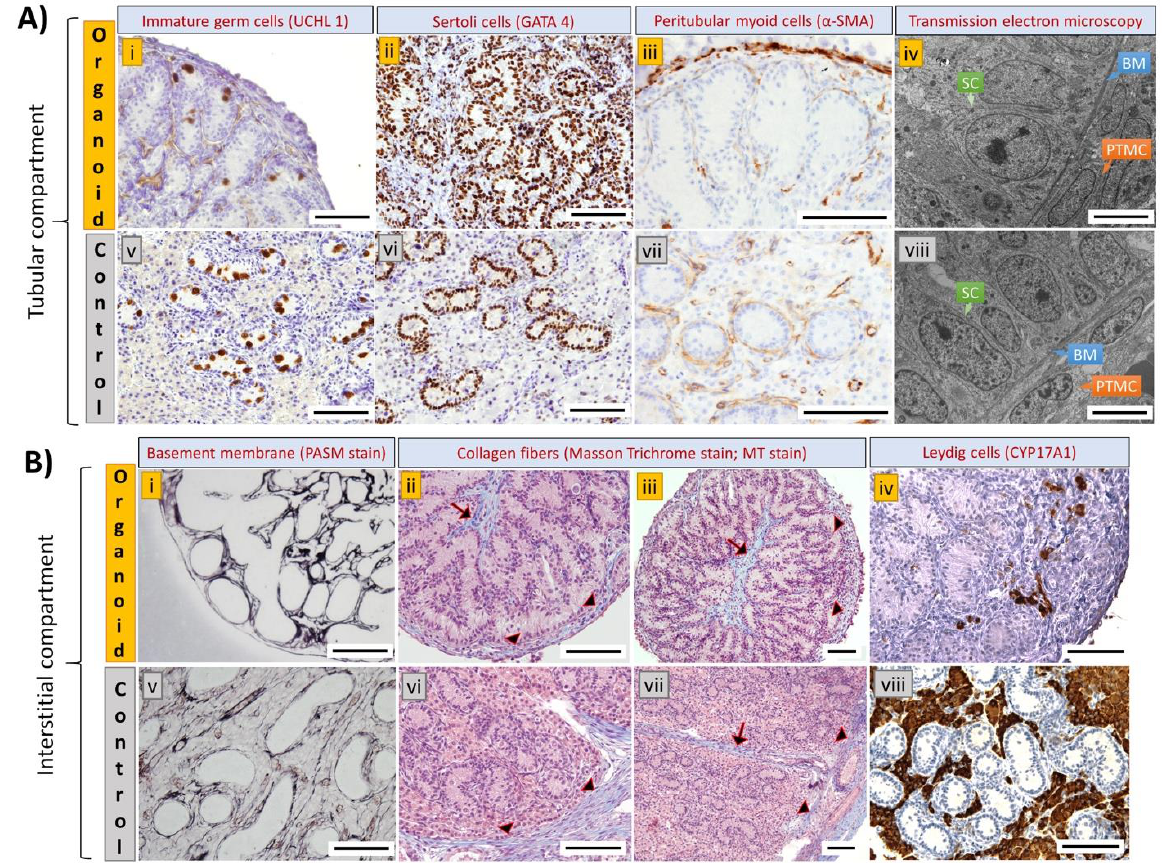
Figure 4. Immunohistochemistry, tissue-specific staining, and transmission electron microscopy (TEM) to detect tubular and interstitial compartments in testis organoids and intact testis tissues from 1-week-old piglets (positive anatomical controls). ( A ) Imaging of the tubular compartment in organoids (upper row) and intact testis tissue (lower row). Immature germ cells ( A ( i )), also known as gonocytes, were detected using UCHL1 and were observed within the tubular structures constructed by Sertoli cells ( A ( ii )) detected by GATA4, and peritubular myoid cells ( A ( iii )) detected by α -SMA. ( A ( iv )) A testis epithelium-like structure constructed by Sertoli cells (SCs), basement membrane (BM), and peritubular myoid cells (PTMCs) was observed in testis organoids as early as 1 week of culture. ( A ( v – viii )) Imaging of intact testis tissues (controls) with the corresponding cell types and structures. ( B ) Imaging of the interstitial compartment in organoids (upper row) and intact testis tissue (lower row). ( B ( i )) Peritubular basement membrane (black) was detected using periodic Schiff-methenamine (PASM) staining. ( B ( ii , iii )) Inter-tubular interstitium (arrows) and peripheral capsule (arrow heads) constructed by collagen fibers (blue) were detected in the organoids using Masson’s trichrome (MT). Also, Leydig cells ( B ( iv )) were detected by CYP17A and were observed in the inter-tubular interstitium. ( B ( v – viii )) Imaging of intact testis tissue (controls) with the corresponding cell types and structures. Scale bars: 100 µ m ( A ( i – iii ), A ( v – vii ), B ( i – viii ); 5 µ m ( A ( iv , viii